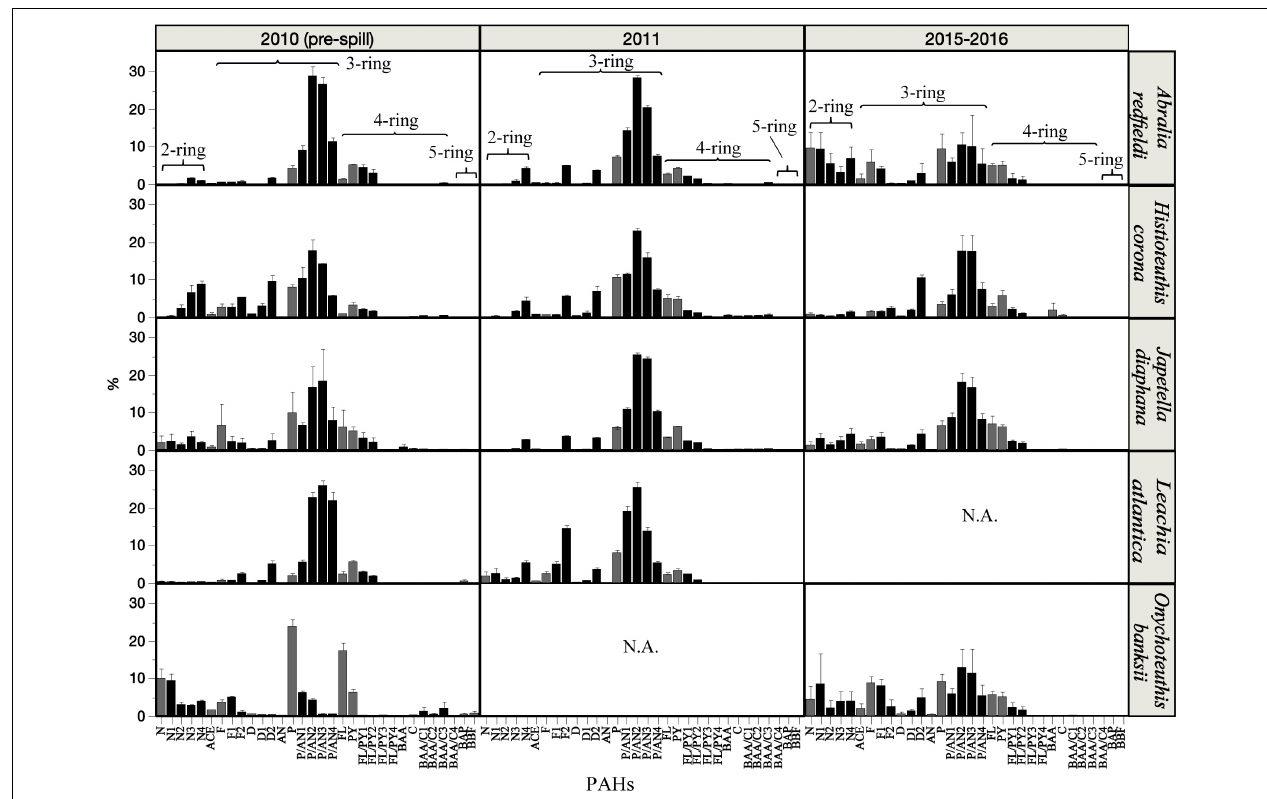
FIGURE 4 | Relative abundance (%) of PAH compounds in the mantle tissue of deep-sea cephalopod species collected in the northern Gulf of Mexico. Sampling years: pre-spill: 2010, post-spill: 2011, and long-term: 2015–2016. Graphs shows gray bars as parent PAHs, and black bars as alkylated PAHs. Data are shown as mean ±